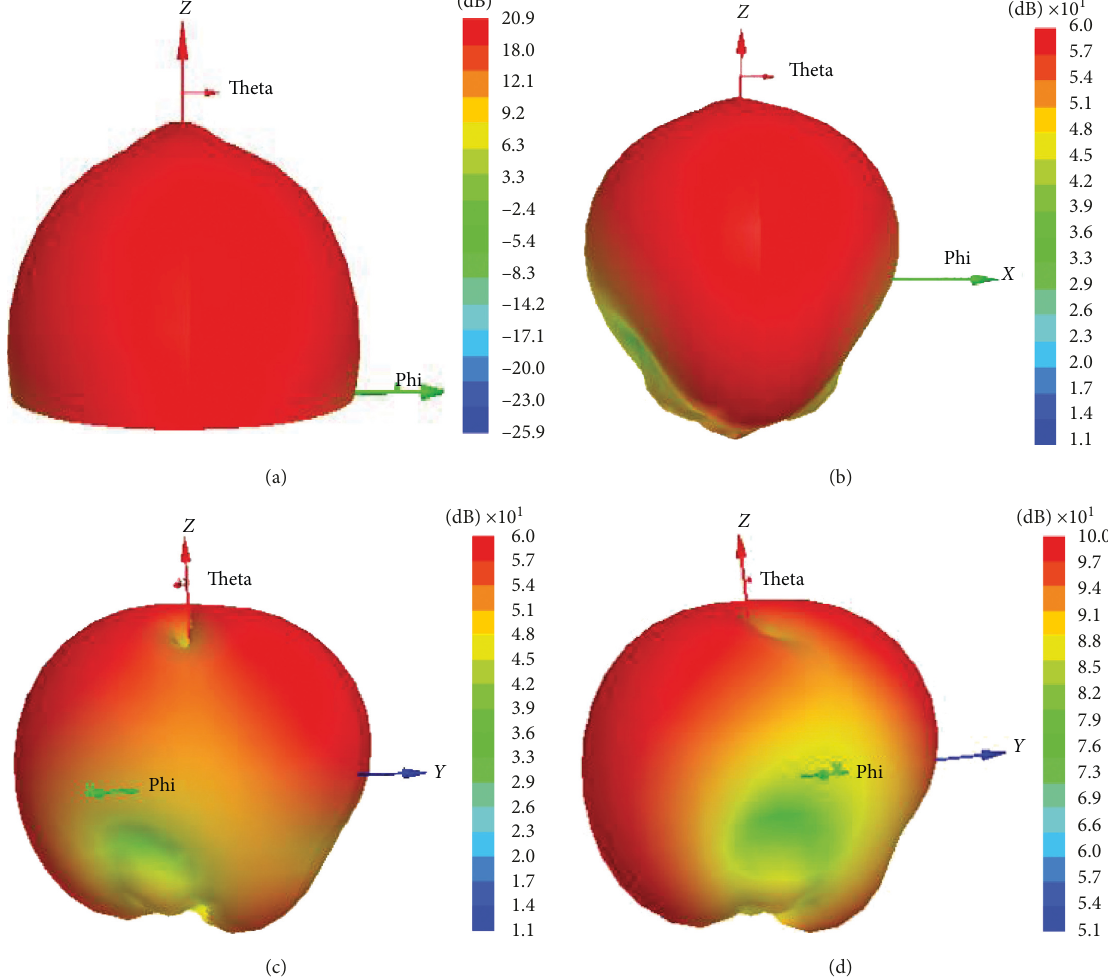
Figure 8: 3D radiation pattern of nanoantenna array at lower and upper resonant frequencies 160 and